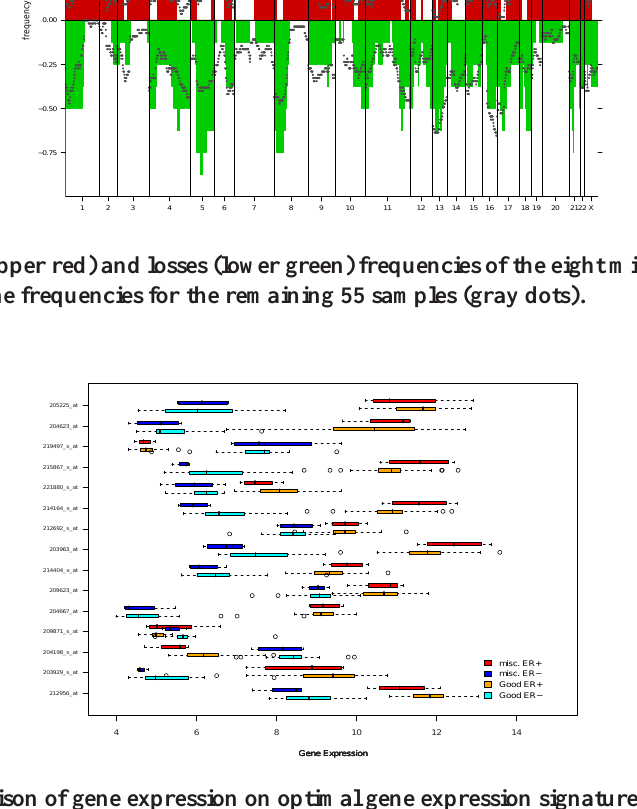
Figure 6: Comparison of gene expression on optimal gene expression signature of the aCGH mis- classified samples with the remaining data. All data are perfectly classified by the selected Affy probes. However, probes such as 212692 s at discriminate within the subset better than within the rest of the